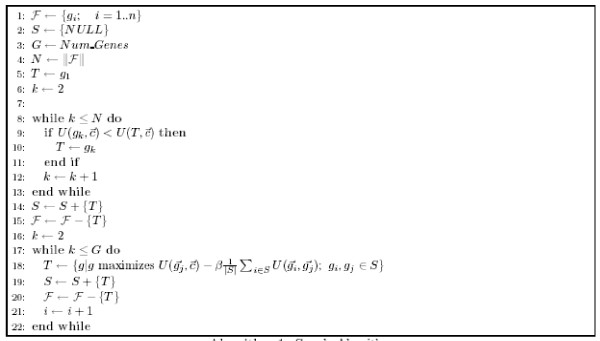
Greedy Algorithm.